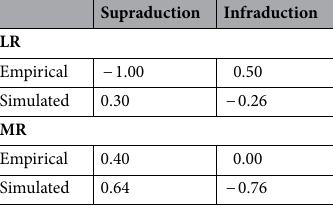
Table 1. Comparison between simulated transverse pulley shifts (mm) in secondary vertical gazes and those measured empirically from MRI data (Clark et al. 4 ).